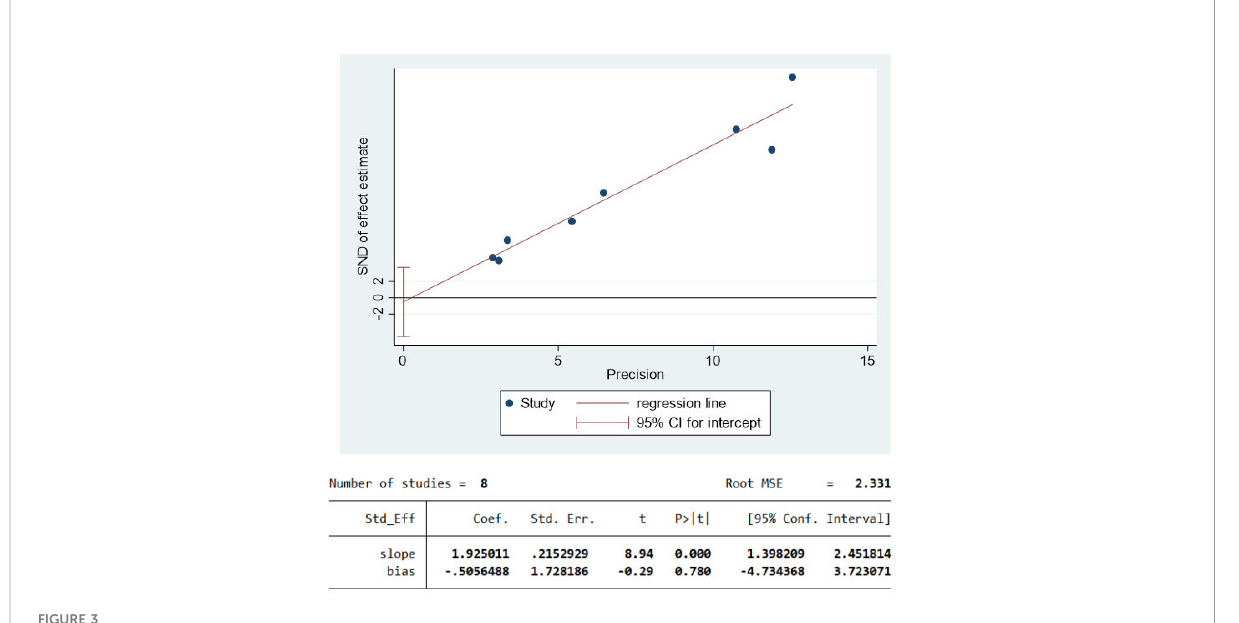
FIGURE 3 Egger ’ s test results.